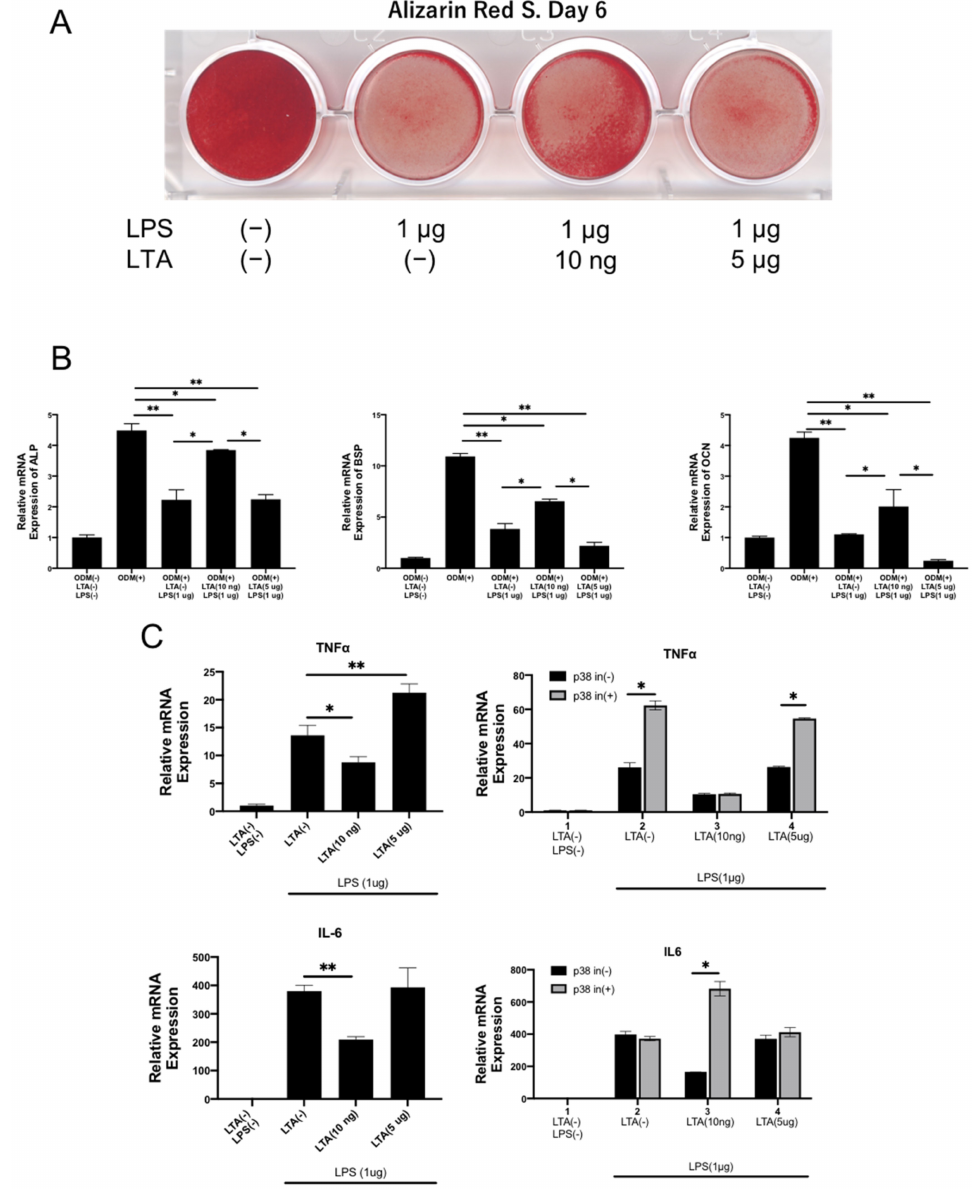
Figure 4. Involvement of TNF- α , IL-6, and p38 signaling in LPS- and LTA-stimulated osteogenic differentiation of MC3T3-E1. ( A ) Effects of LPS and LTA on osteogenic differentiation of MC3T3-E1 cells. MC3T3-E1 cells were cultured in an osteogenic induction medium with LPS only (1 µ g/mL)